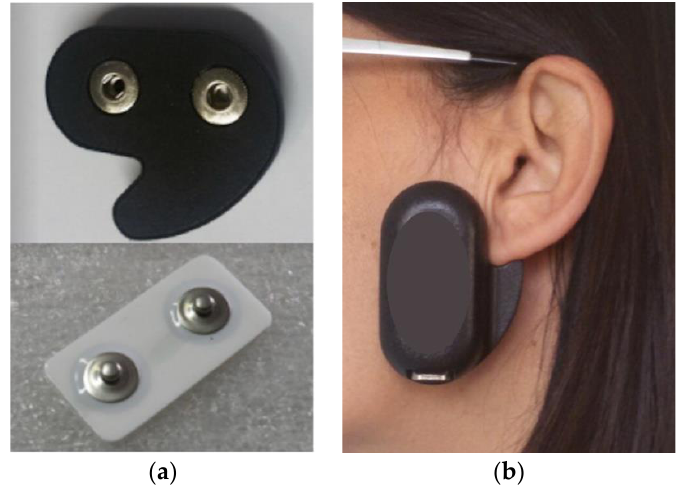
Figure 1. ( a , b ) Device used in this investigation.